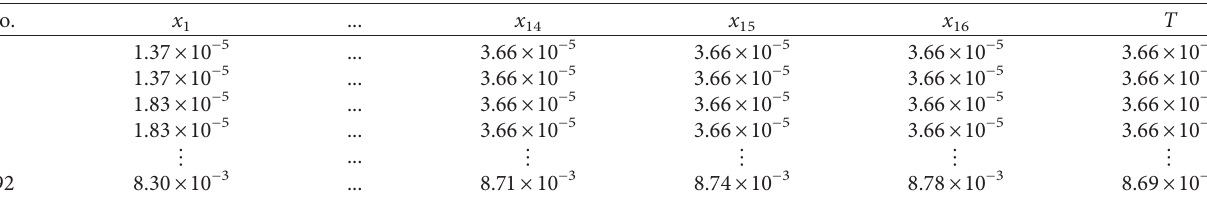
Table 3: Dataset of this research after being